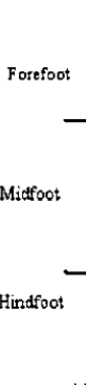
Fig. 2. Foot Model proposed by Guihard et al., 2004